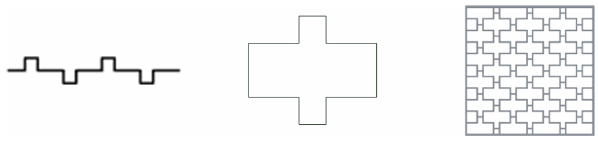
Figure 9. Evolution of the second pattern.